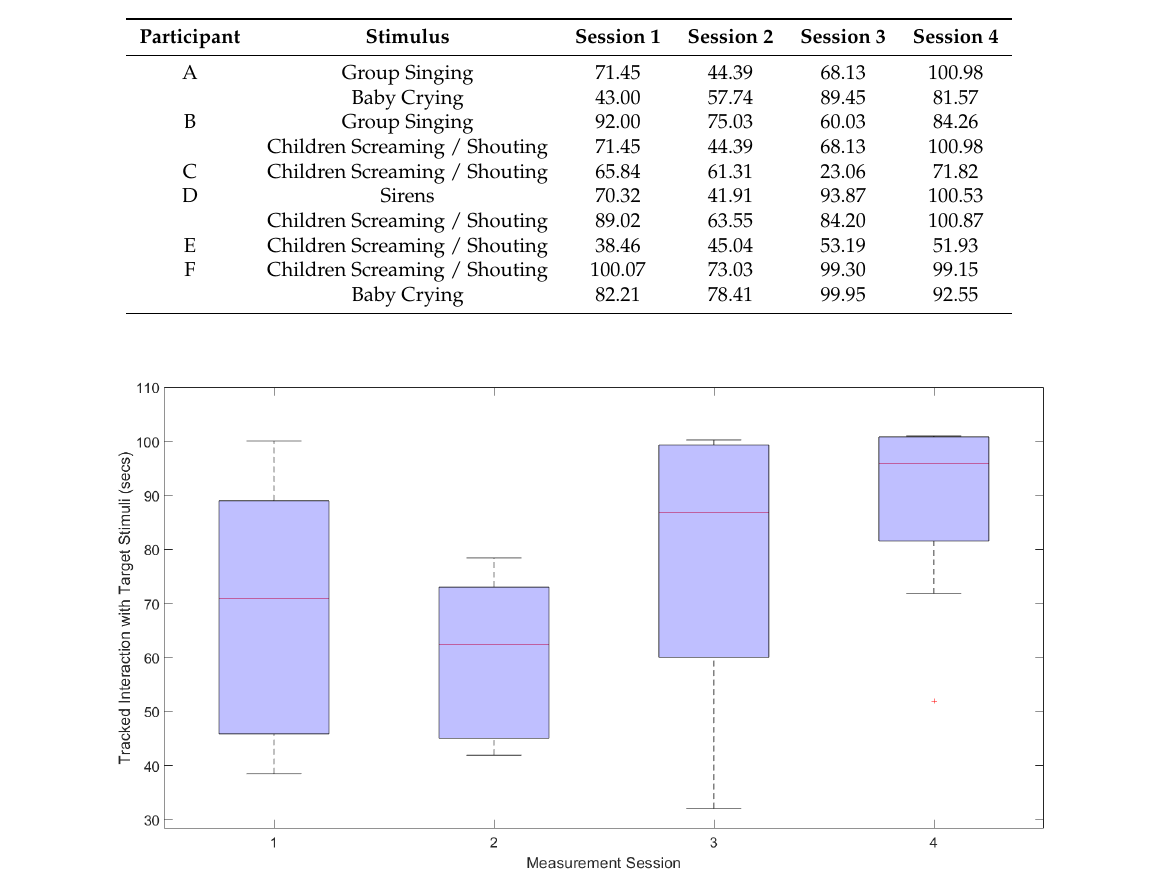
Table 4. Participant tracked interaction time for each target stimuli across all four experimental sessions, represented in seconds.